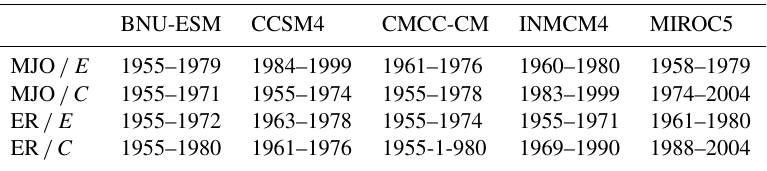
Table 5. Periods used for the statistics of Figs. 10 and